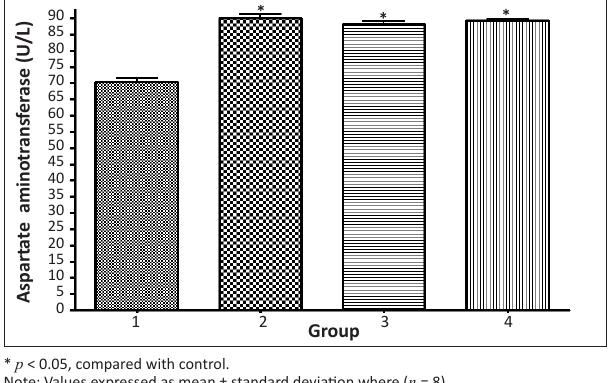
Figure I : Effect of calcium hypochlorite on alkaline phosphatase (ALP) activity * p < 0.05, compared with control. Values expressed as mean ± S.D where ( n = 8). Asterisks indicate significant ( p <0.05) Note: Values expressed as mean ± standard deviation where ( n = 8). difference compared with control. FIGURE 1: Effect of calcium hypochlorite on alkaline phosphatase activity.